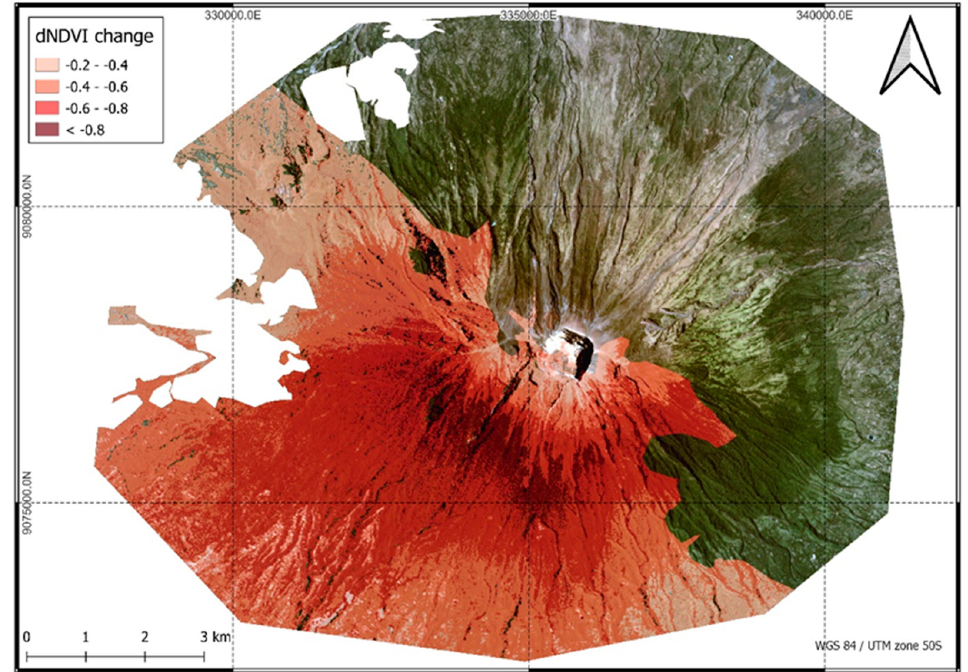
Figure 3. Ash deposits at Agung (I) after the eruptions around 21 November 2017 based on dNDVI changes. Areas with large negative dNDVI values represent strong vegetation changes or ash deposition. Background: PlanetScope pre-scene (18 September 2017). The classification could only cover partial areas to the S and SW of Agung due to strong cloud coverage at the post-scene.